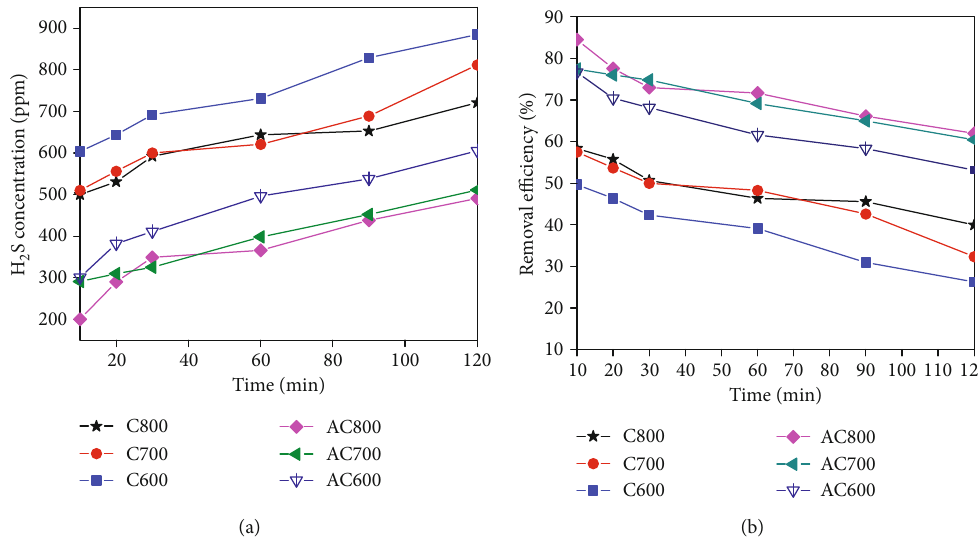
Figure 5: E ff ect of carbonization temperature on the samples ’ adsorption performance: (a) H e ffi ciency. Test conditions: m = 0 : 20 g , FR = 0 : 03 m 3 /h , KOH:C 1: 1, C